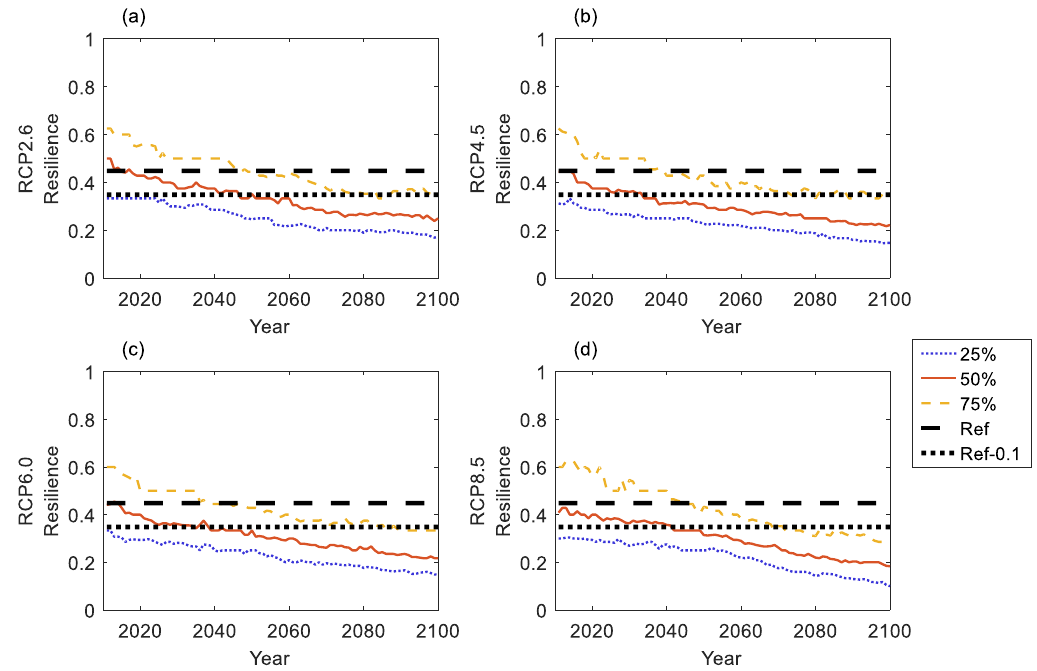
Figure 7. Resilience under RCP 2.6 ( a ), 4.5 ( b ), 6.0 ( c ), and 8.5 ( d ) for a 40-year moving window, with the horizontal axis being the last year of the window. The thick dashed and dotted lines represent the reference historical performance and 10% worse-than-the-reference value, respectively.